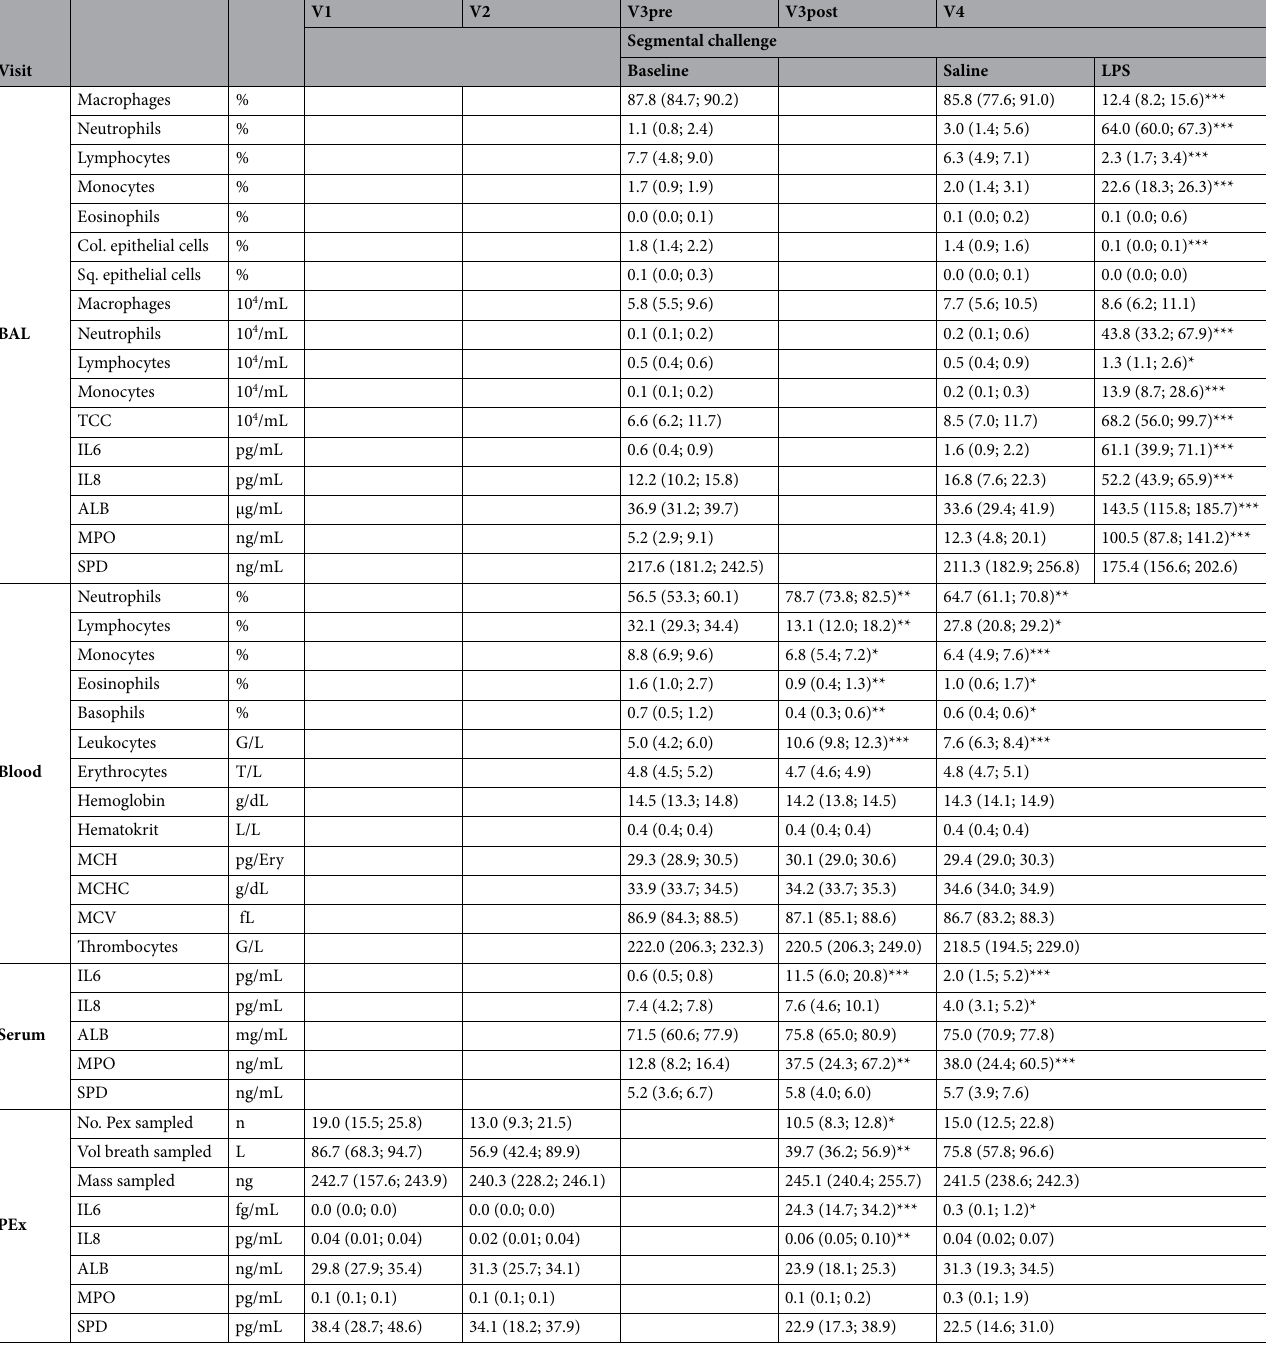
Table 1. Summary of the inflammatory response in bronchoalveolar lavage (BAL), blood/serum and PEx for segmental LPS challenge (V1–V4). PEx: concentration in 200 µL eluate from half a filter membrane (PEx mean mass 120 ng). Concentration*0.2/120 ng will give the estimated concentration in ELF. *p < 0.05,**p < 0.01,***p < 0.001. Median and